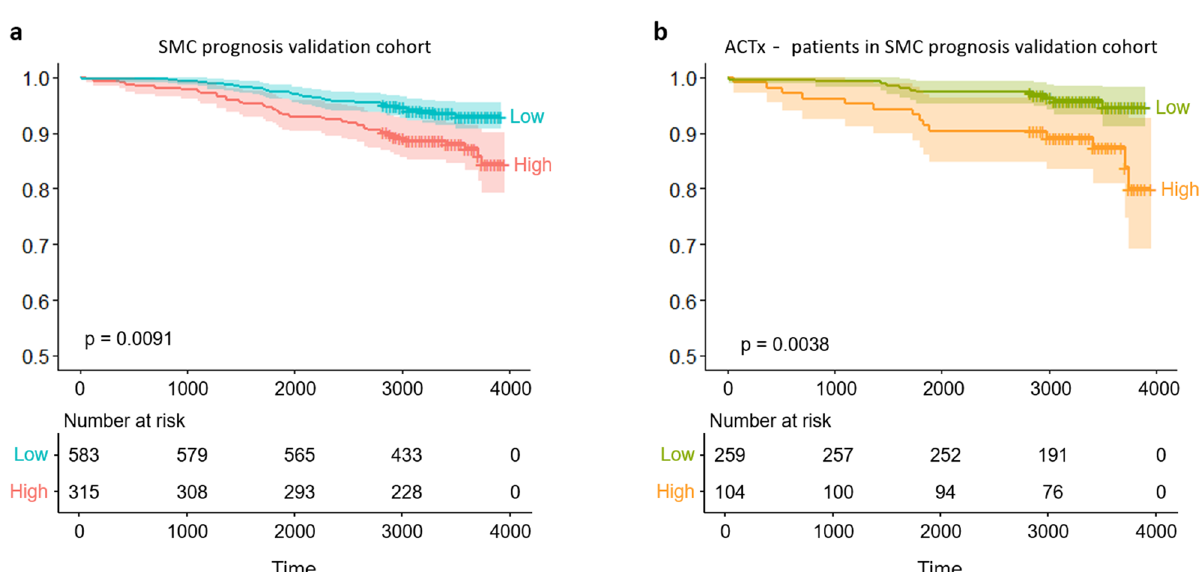
Figure 3. Time to disease recurrence survival analysis using the prognosis validation cohort. ( a ) The overall patient DFS was divided into two groups based on the predicted Oncotype DX threshold score in the prognosis validation cohort. ( b ) DFS of patients without adjuvant chemotherapy